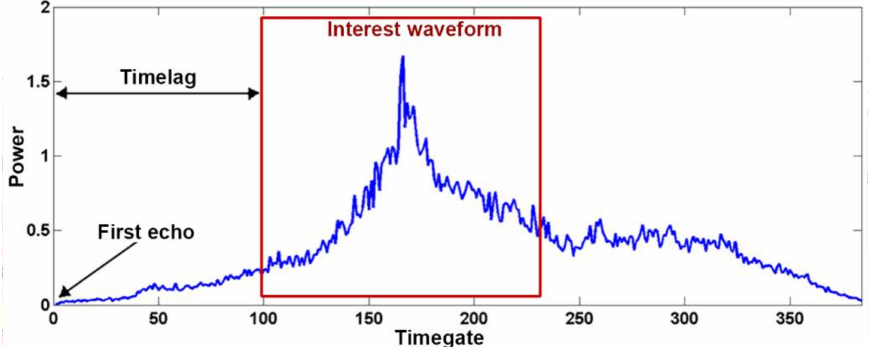
Figure 3. Example of a “raw” waveform simulated using the Continental waveform ALtimetry Model (CALM). We show the position of the first return signal, the time lag duration, and the interest waveform window (here composed of 128